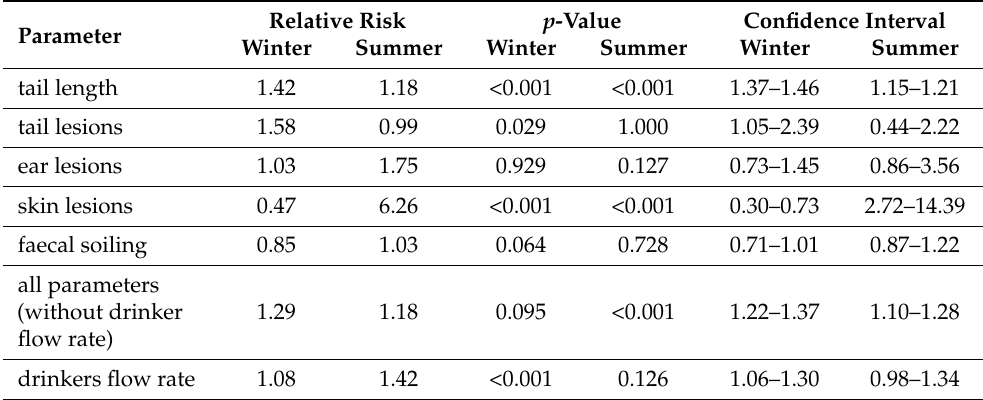
Table A2. Relative risk, p-value, and confidence intervals for the parameters in the winter